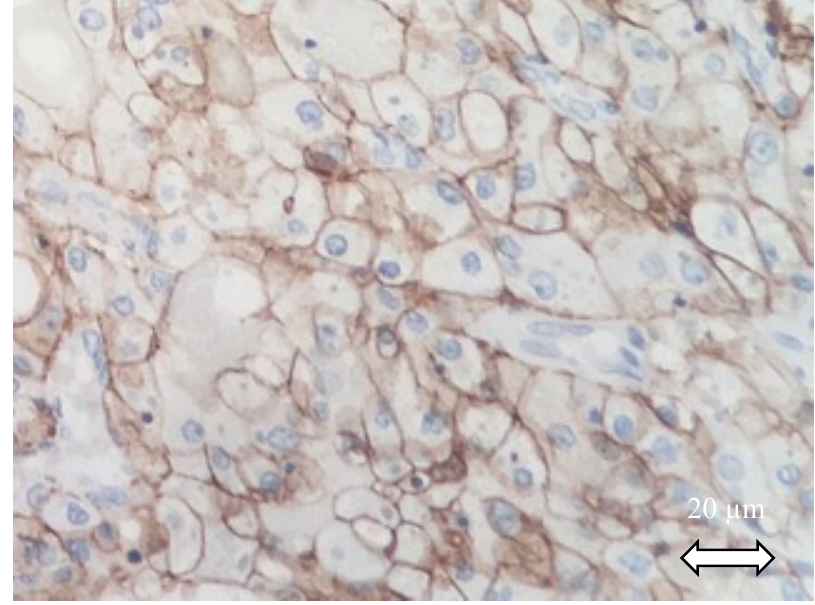
Figure 2. CAIX staining of a clear cell renal cell carcinoma. Tumor cells exhibit diffuse CAIX membranous immunoreactivity.